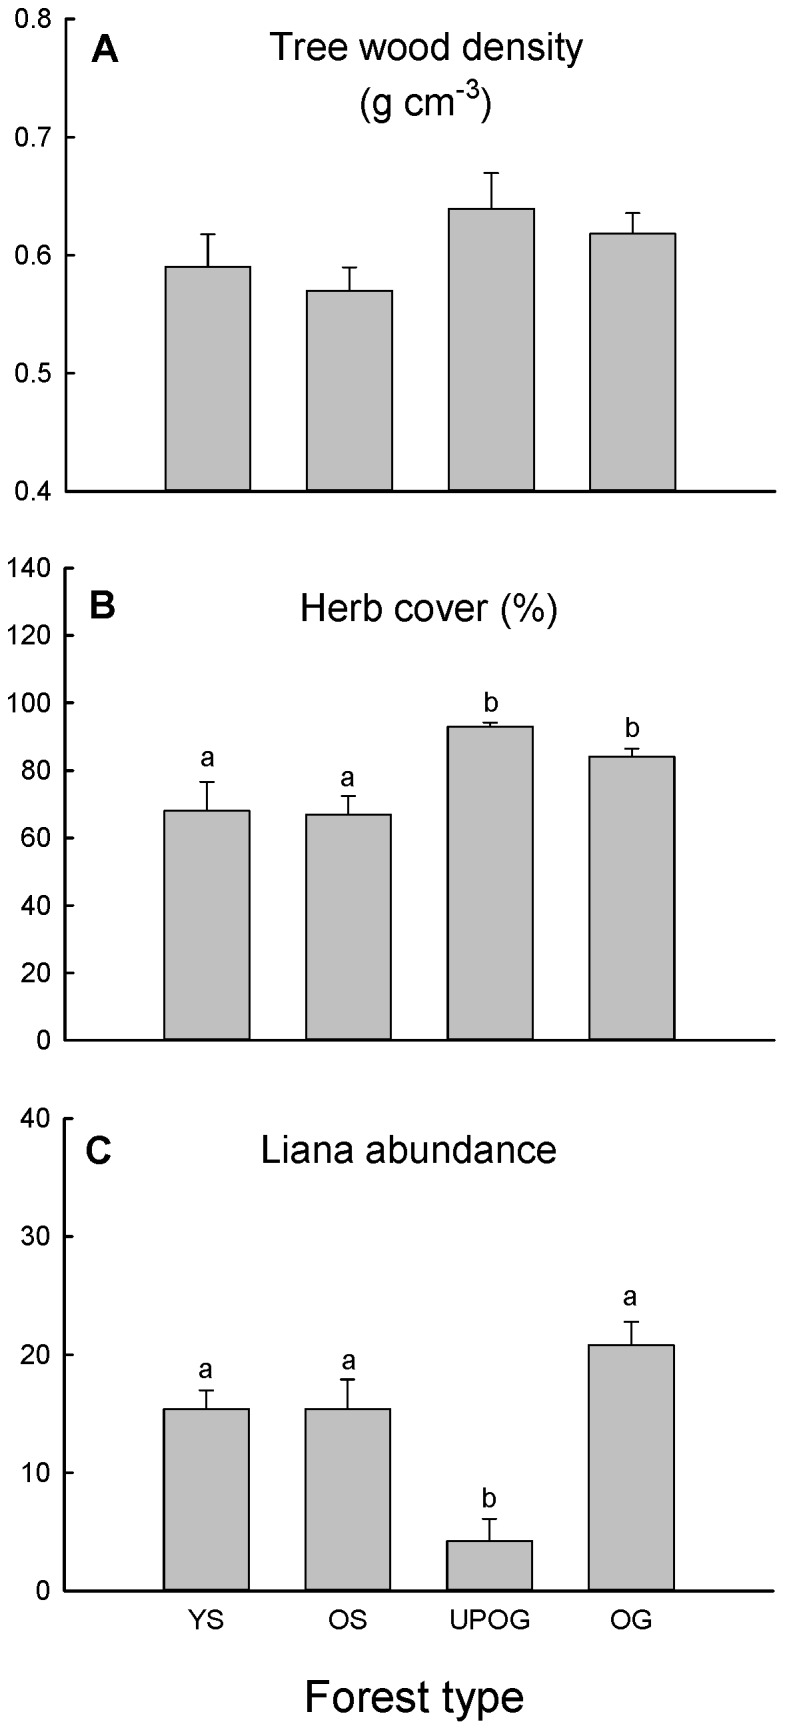
Basal area weighted tree oven-dry wood density, percent herb cover, and liana abundance for different forest types.YS represents young secondary forest; OS represents old secondary forest; UPOG represents understorey planted old-growth forest (the old-growth forests with Amomum villosum plantation in the understorey); OG represents old-growth forest. Bars are means+standard error (SE). Bars topped by different letters indicate significant differences between forest types (P<0.05).